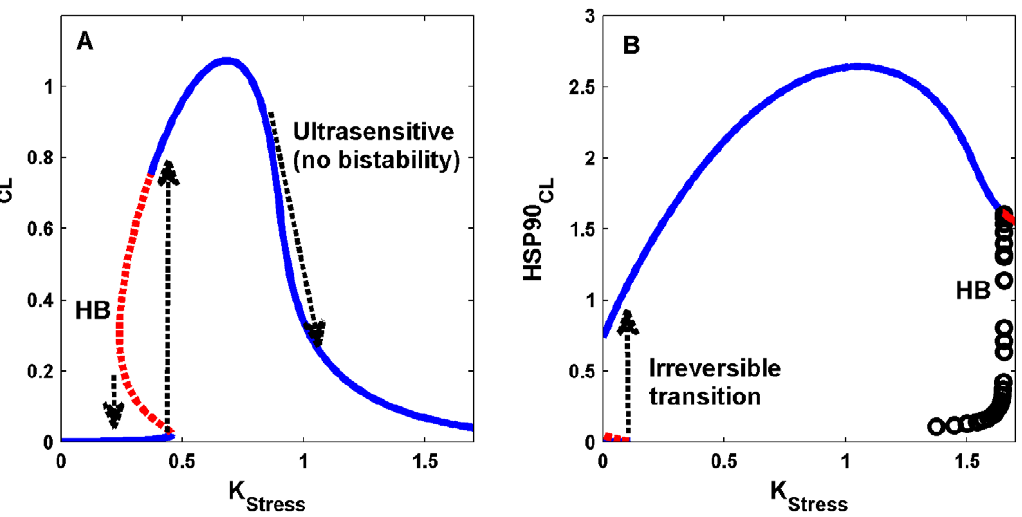
Figure 8. Observation of different dynamical scenario for the parameter set obtained from fitting the time series data by global optimization. Loss of mushroom-like dynamics in the full ordinary differential equation (ODE) model with k stress as the bifurcation parameter. (A) The Z-shaped bistability is lost, but ultrasensitivity is retained. A mushroom-like dynamics is possible without any memory effect at high chronic stress due to loss of Z-shaped bistability. (B) Irreversible transition in the S-shaped bistability is observed. Z-shaped bistability is lost and it is replaced by Hopf bifurcation with a very low period. The parameters used to simulate the dynamics for each of the cases are given in a separate file (Model file S2).